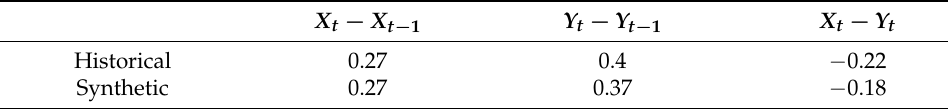
Table 4. Comparison of historical and simulated rank correlations.